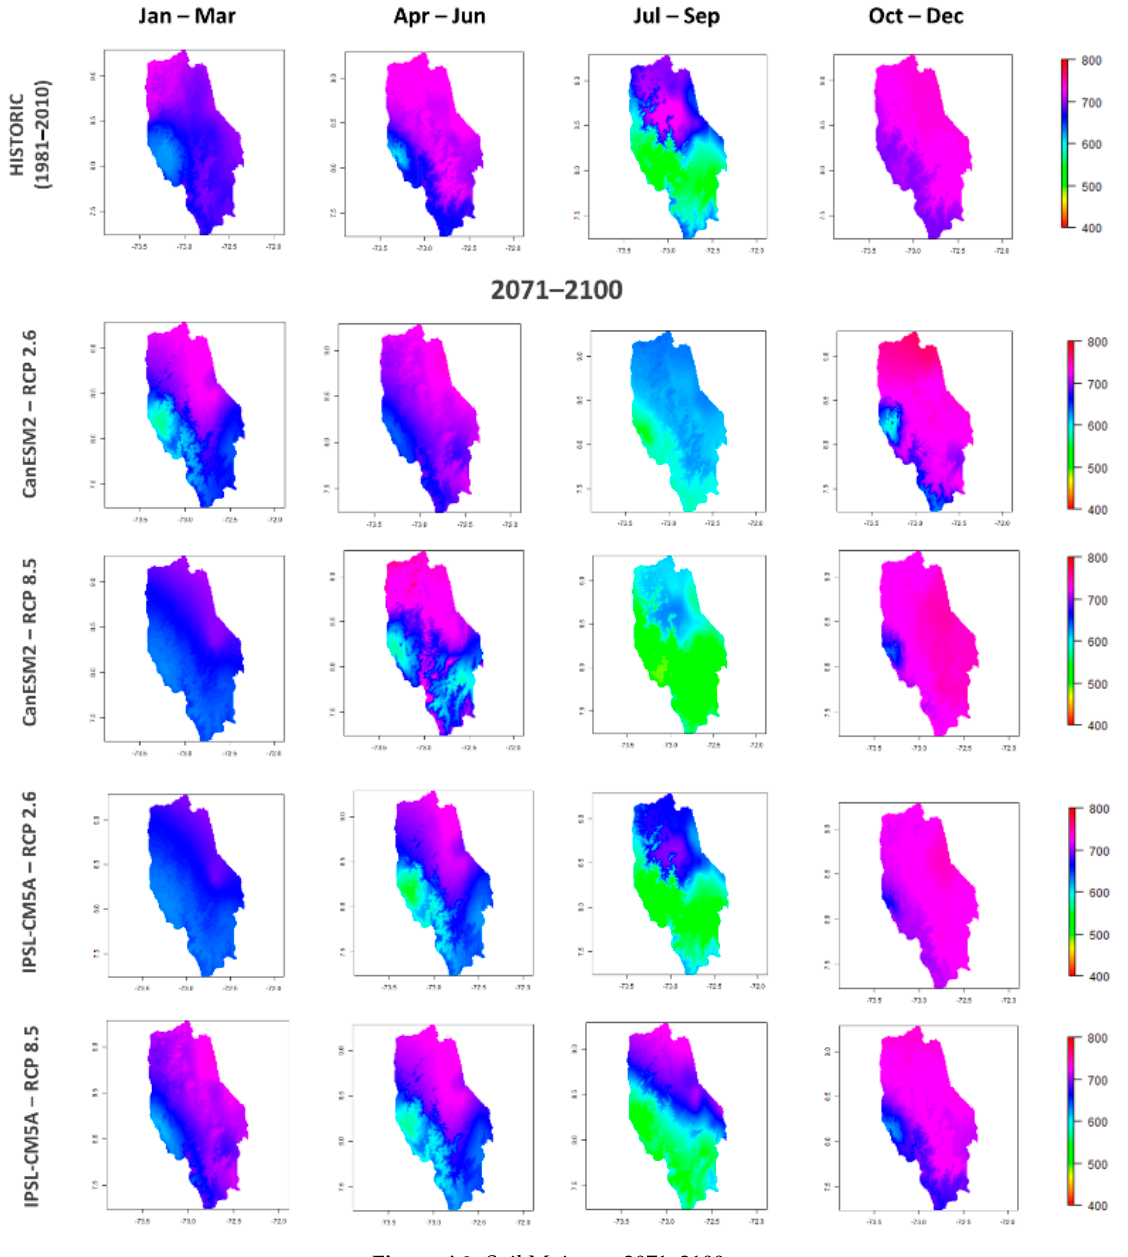
Figure B4. Soil Moisture 2071–2100 Figure A8. Soil Moisture